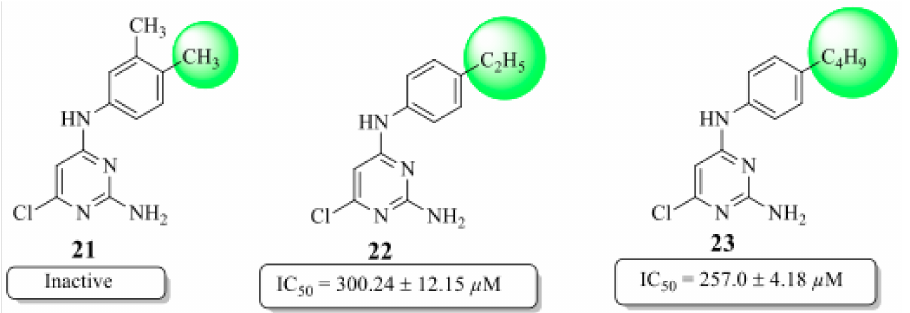
Figure 5. Comparison of β -glucuronidase inhibitory activity of compounds with a 4-alkyl substitution at the benzene